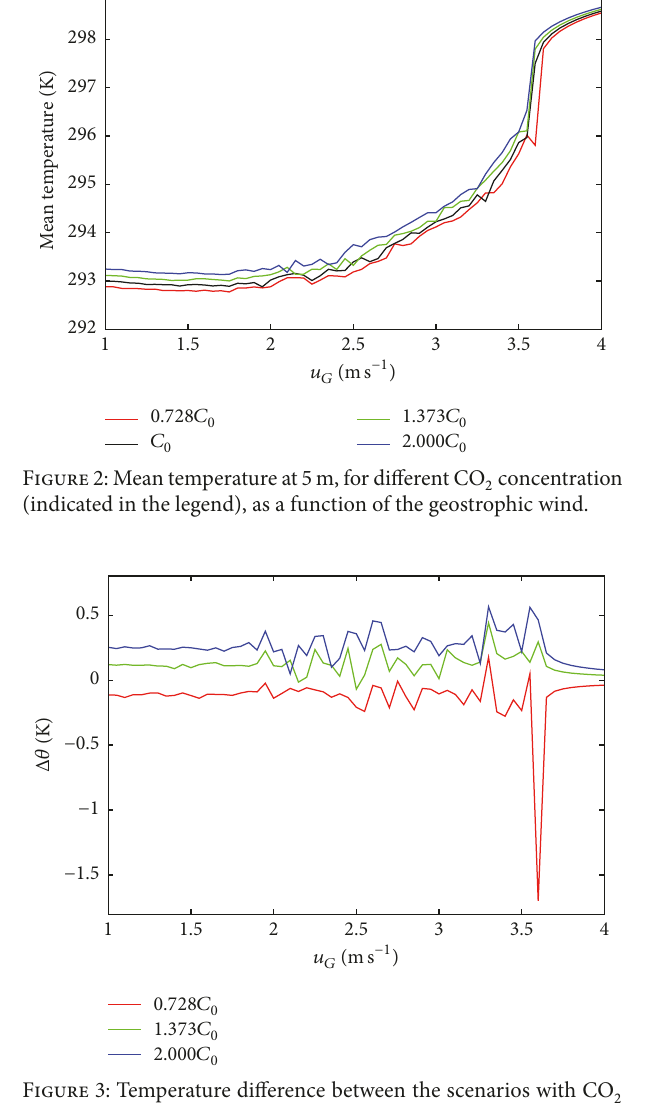
Figure 5: Temperature difference between the scenarios with 20% of clod covering and clear skies, for different CO 2 concentration (indicated in the